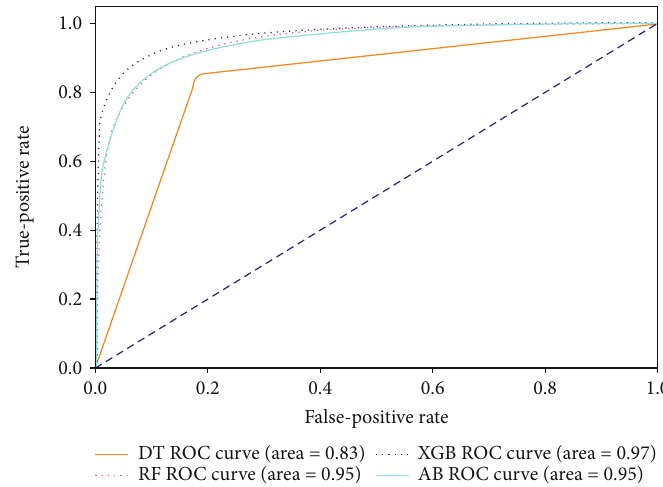
Figure 3: ROC curve of all algorithms. Abbreviations: DT: decision tree; RF: random forest; AB: AdaBoost; XGB: